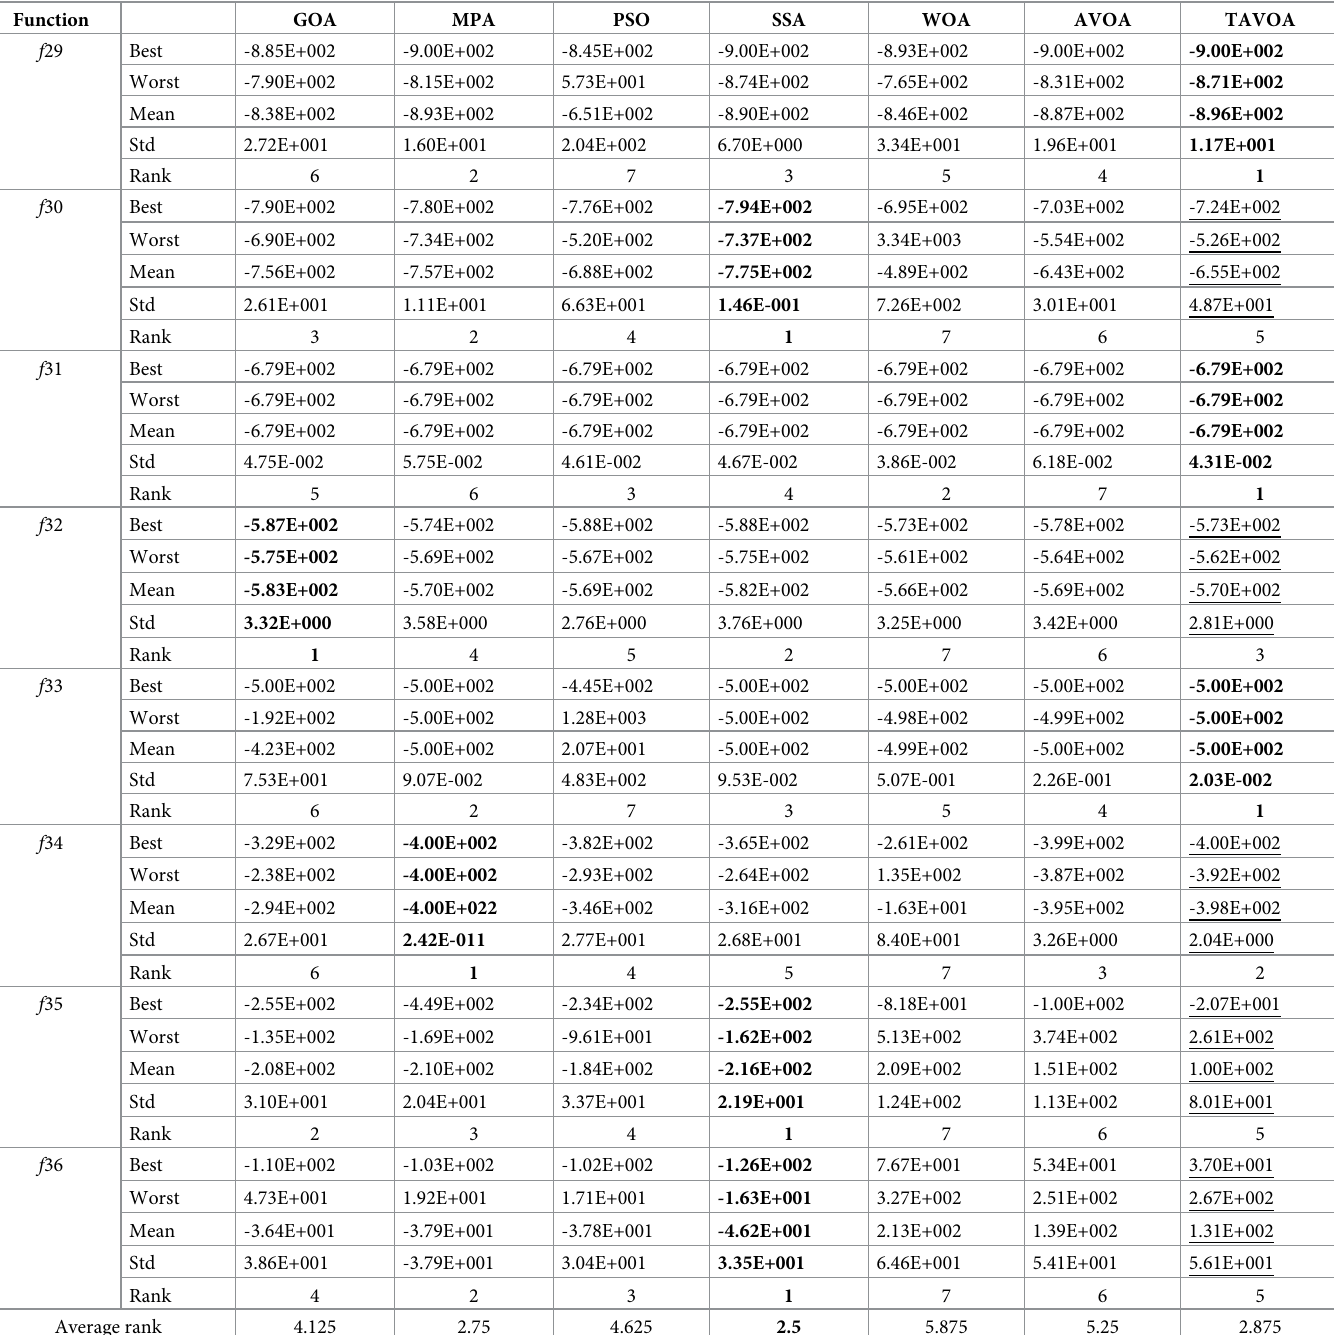
Table 8. Experimental results of CEC 2013 basic multimodal benchmark functions ( f 29 − f 36).